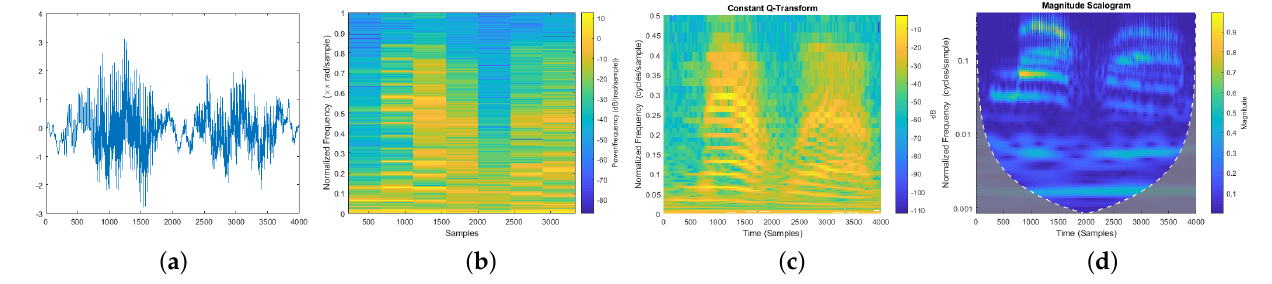
Figure 8. Time-frequency transformations. ( a ) A sample signal, ( b ) Basic spectrogram using Fourier transform, ( c ) Constant Q transform (better resolution at low frequencies), ( d ) Continuous Wavelet transform (best resolution for non-periodic signals).